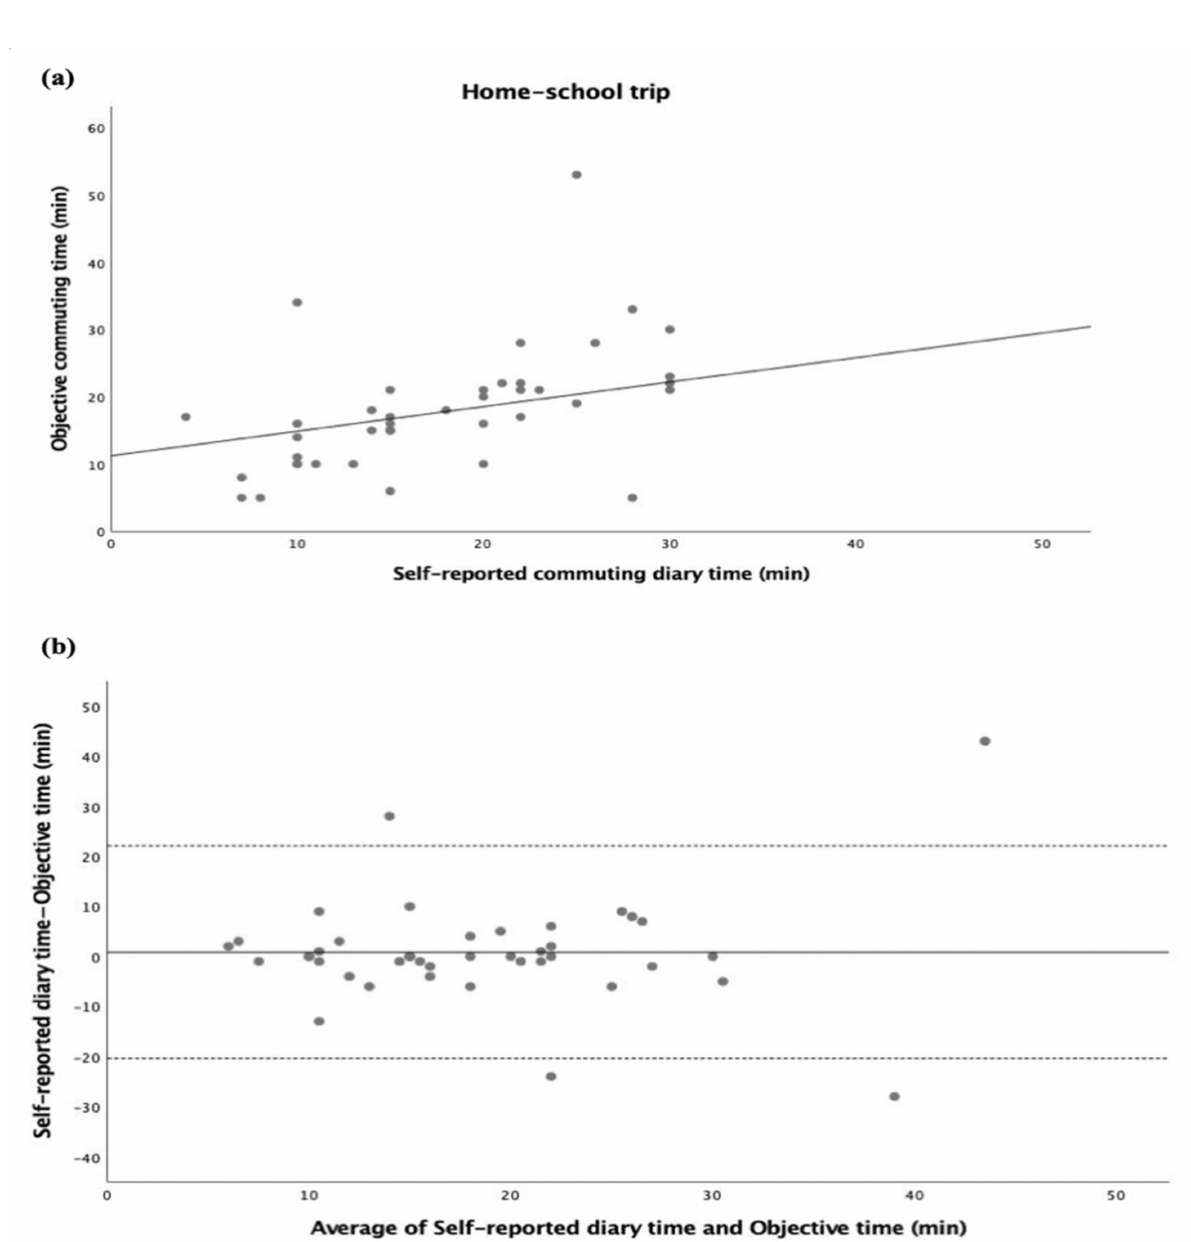
Figure 4. Commuting time expressed as minutes (home–school trip). ( a ) Regression of the objective commuting time (y) vs. (x) the self-reported commuting diary time. The regression equation is y = 11.23 + 0.36x. ( b ) Bland–Altman plot of the commuting time of the home–school trip between self- reported diary time and objective time (y) vs. average of self-reported diary time and objective time (x). The central dotted line represents the mean of differences between the objective time measure and the self-reported time measure; the upper and lower dotted lines represent the upper and lower 95% limits of agreement (mean differences + 1.96 standard deviations of the differences),